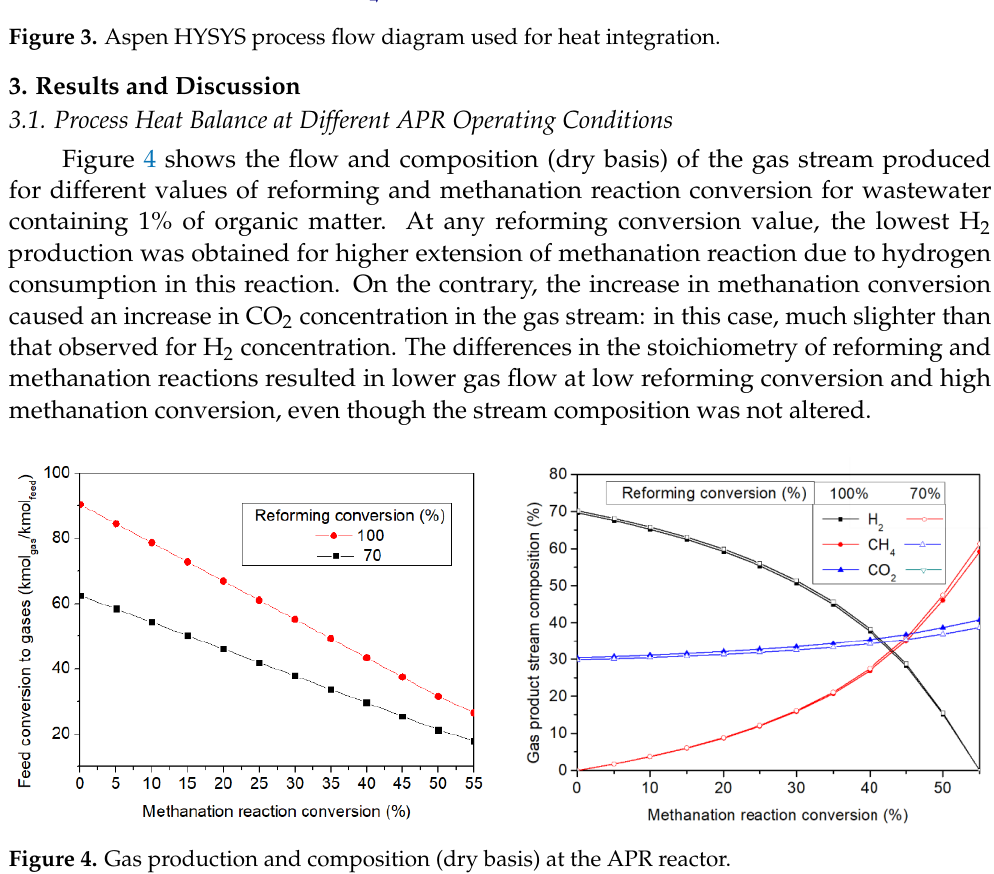
Figure 3. Aspen HYSYS process flow diagram used for heat integration.